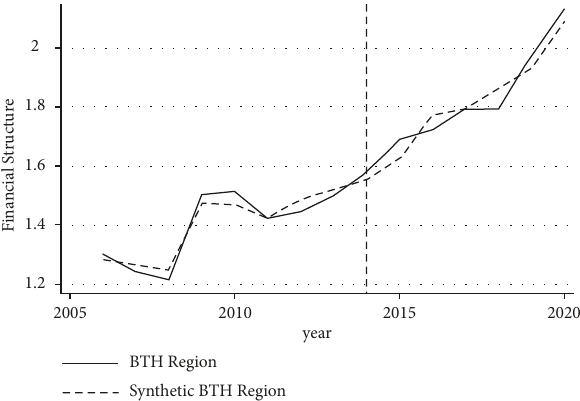
Figure 6: The BTH region and the synthetic BTH region’s financial structure change